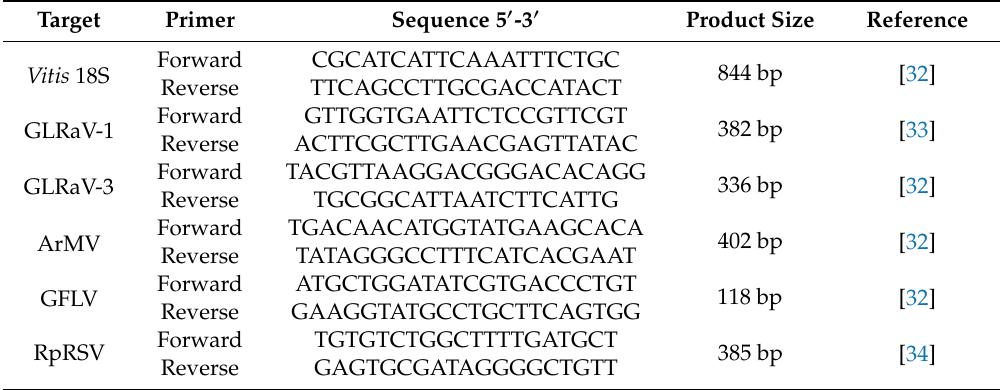
Table 3. Primer sequence and product size.